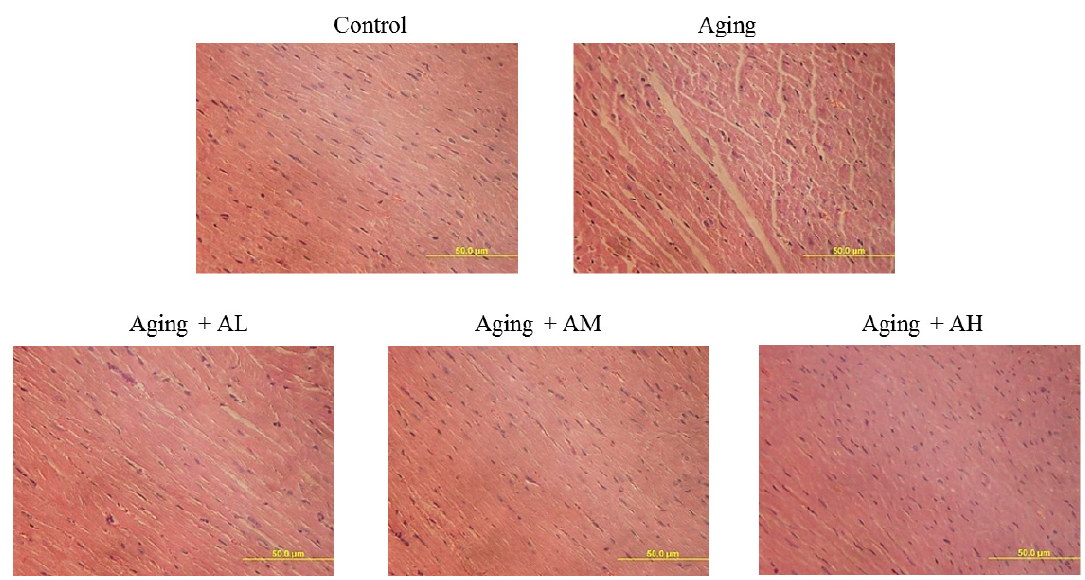
Figure 2. Morphological changes of rat cardiac tissue with Hematoxylin–Eosin (H&E) staining. Cardiac tissue sections stained with hematoxylin and eosin. The images of cardiac architecture were magnified ×400. The scale bar is 50 μ m.